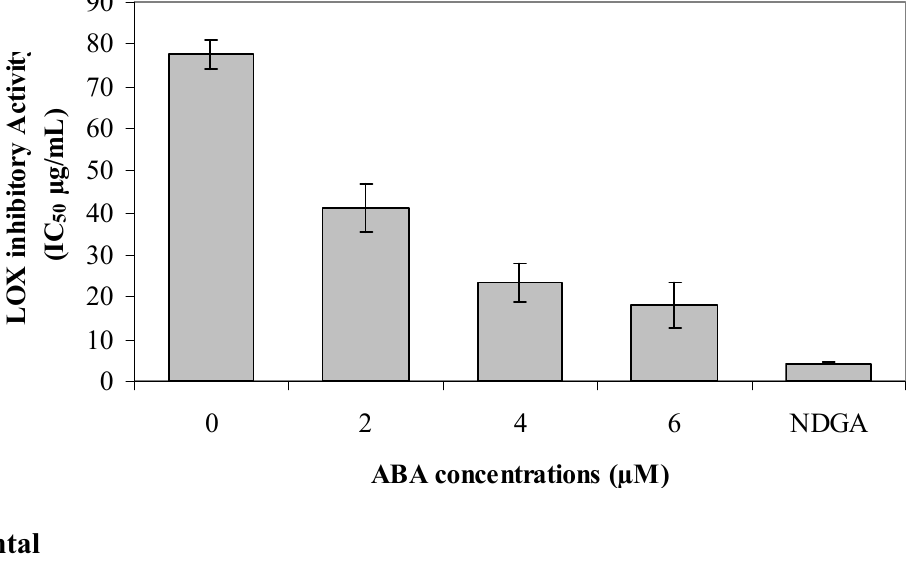
Figure 2. Effect of ABA levels on lipoxygenase inhibitory activity of O. stamineus Benth (µg mL − 1 ); Nordihydroguaiaretic acid (NDGA) was used as a [expressed as IC 50 positive